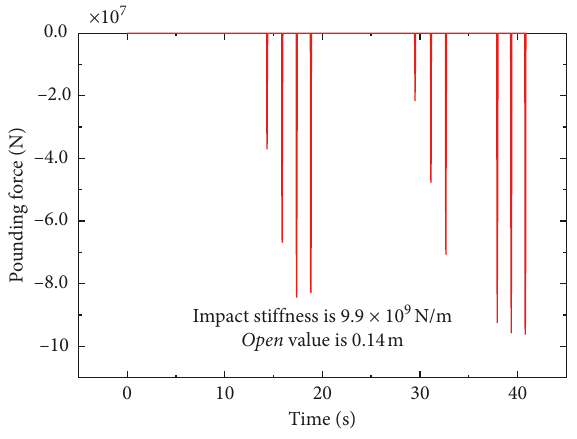
Figure 5: Time history of collision force.